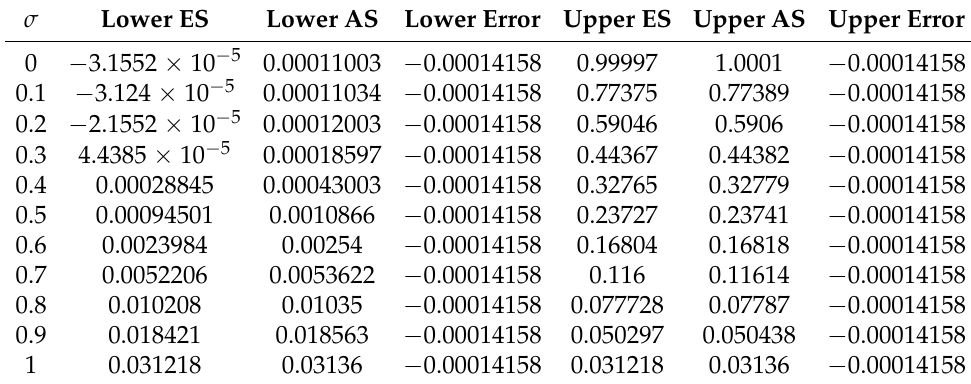
Table 1. Table for the error term between exact solutions (ES) and approximate solutions (AS). σ Lower ES Lower AS Lower Error Upper ES Upper AS Upper